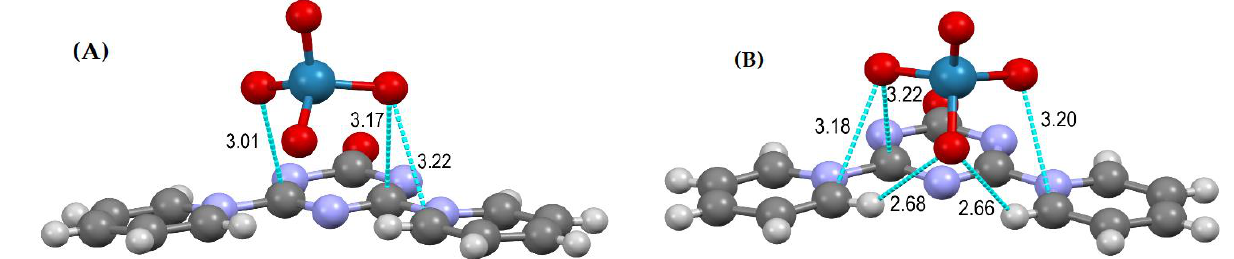
Figure 9. Ion pairs formed by ( A , B ) cations with perrhenate anions.